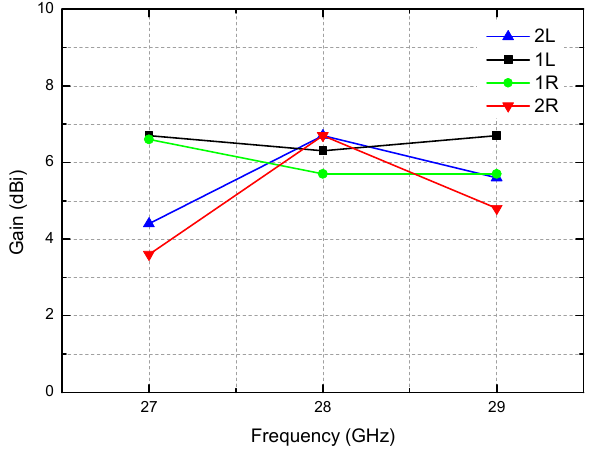
Figure 12. Antenna gains versus the frequency for the four directional